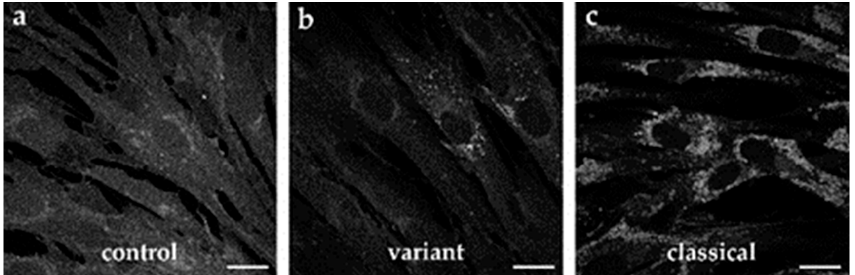
Figure 3. Biochemical heterogeneity of cultured skin fibroblasts after filipin staining. ( a ) Control fibroblasts, ( b ) the patient reported in this study showed a variant NP-C1 phenotype (V1023Sfs*15/G992R), ( c ) a classical NP-C1 mutant with compound heterozygous mutation (P543Rfs*20/E612D) is shown for comparison. Scale bar = 20 µm.